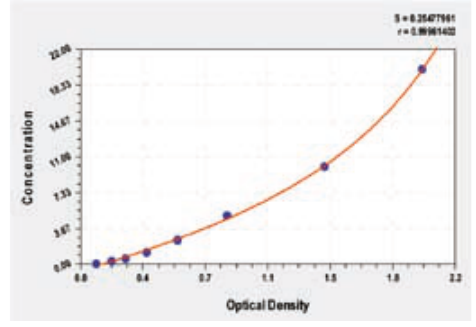
table1. Serum NT-pro BNP finding Group